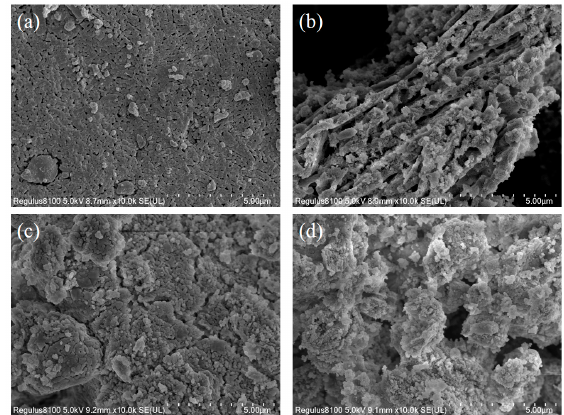
11 of 15 Figure 7. Decomposition kinetics in the 2nd and 12th cycles: ( a ) the time evolution of decomposition ratio; ( b ) the time evolution of decomposition rate. The microstructure test shows that the calcined limestone exhibits plain surfaces and BF 0.5 -Al obtained by the biotemplating method exhibits more hierarchical structures, as compared between Figure 8a,b. Valverde et al. [10] demonstrated that a less porous struc- ture corresponded to a decrease in the heat released from exothermic reaction. Ma et al. [30] proved that the better pore characteristics favored the better contact between CaO particles and CO 2 , resulting in the higher carbonation degree. The sintering of limestone after 10 calcination/carbonation cycles can be observed with the agglomeration of CaO particles denoting coarsening, as shown in Figure 8c. Moreover, the surface of limestone is broken into smaller pieces due to the local densification. The grain growth due to sin- tering problem generates physical barriers to CO 2 diffusion, which leads to the decreased carbonation conversion and energy storage density. Further, BF 0.5 -Al shows slight densi- fication and is less affected by the cyclic reactions at high temperature, as shown in Figure 8d. The result can be attributed to the difference in pore distribution during synthesis and